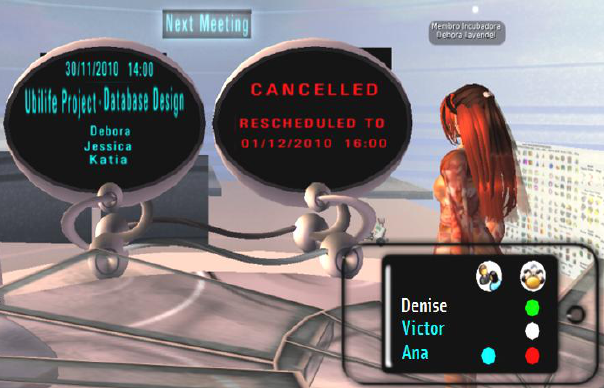
Figure 5. Meetings